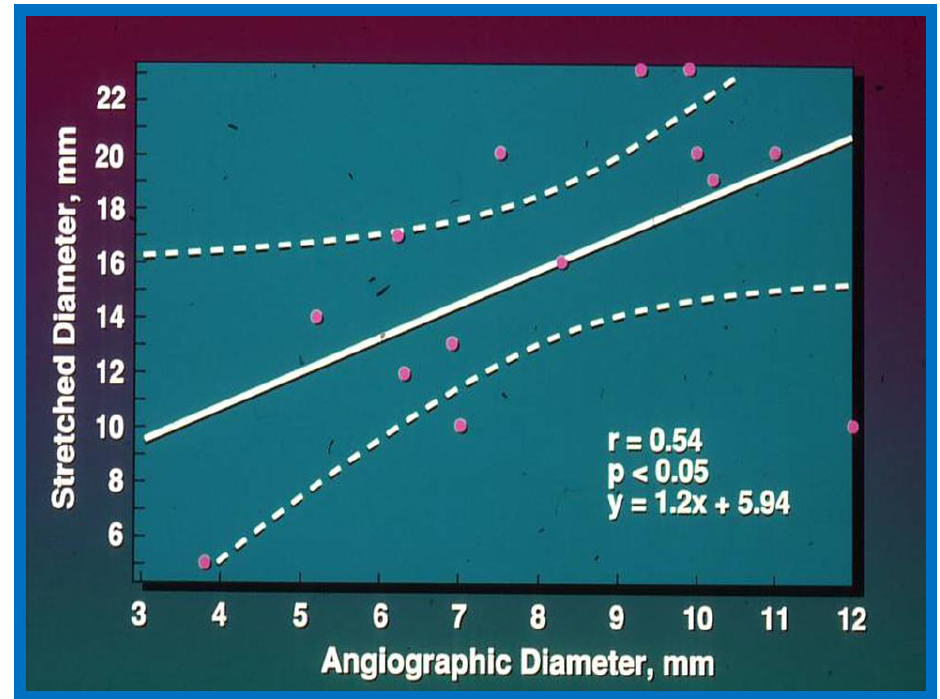
Figure 2. Plot similar to Figure 1 showing the relationship of angiographic diameter of the atrial septal defect with stretched diameter of the atrial septal defect: Note significant ( p < 0.05) correlation with an r value of 0.55. Reproduced from Rao P.S., et al. [2].